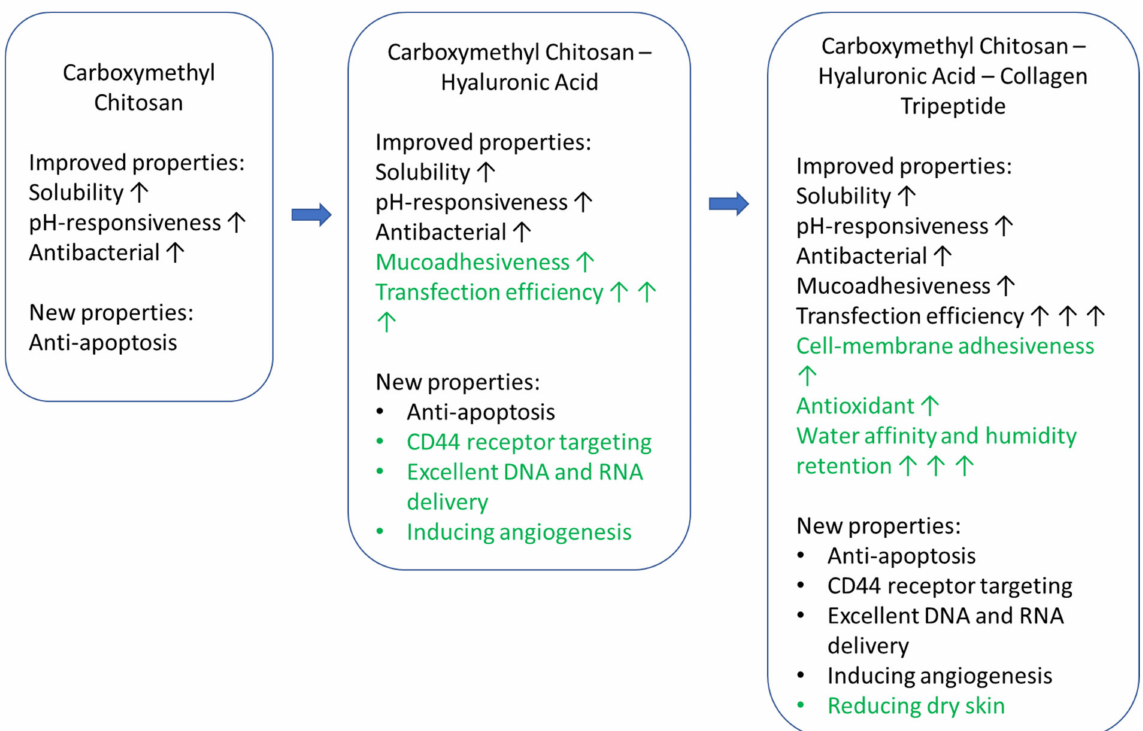
Figure 2. The potential improved and new properties of carboxymethyl chitosan—hyaluronic acid— collagen tripeptide complex. Note: ↑ for enhanced properties and ↑↑↑ significantly improved